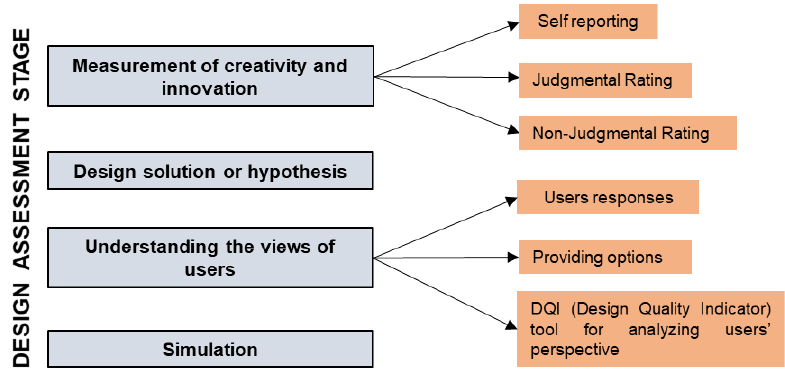
Figure 4. Stage 3: design assessment in design process (source: created by